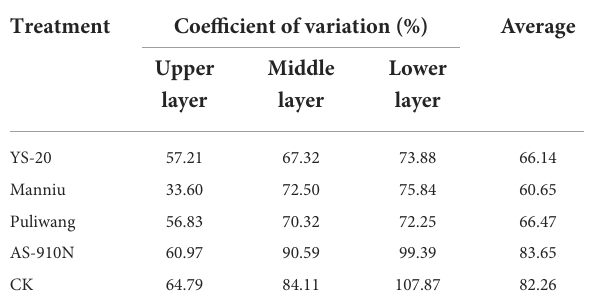
TABLE 3 Effect of aerial spray with adjuvants on the droplet uniformity sprayed by UAV.